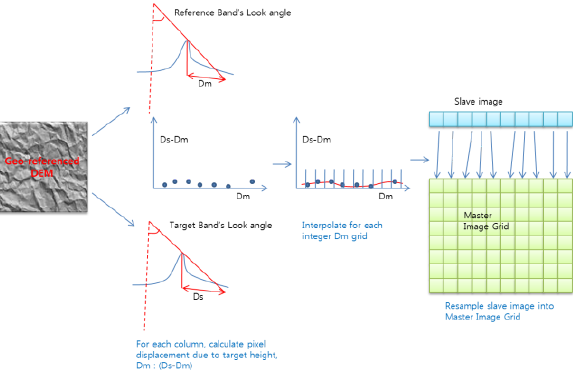
Figure 2. The Procedure of Terrain Relief Correction